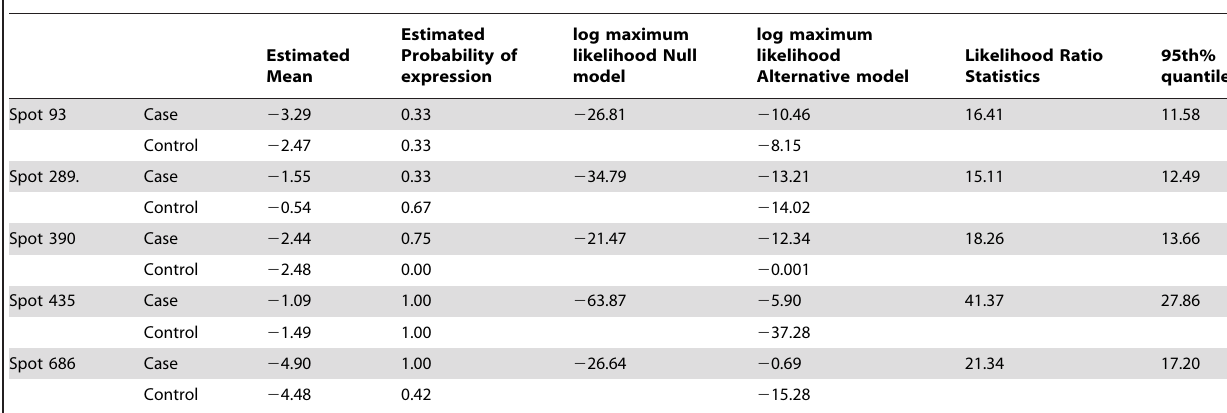
Table 5. Five differentially expressed spots identified by the Likelihood Ratio Test.